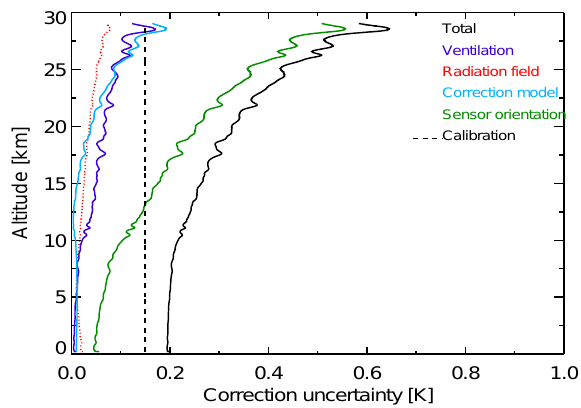
Figure 9. Contributions of the various uncertainty terms to the Fig. 9. Contributions of the various uncertainty terms to the total uncertainty estimate of the GRUAN temper- total uncertainty estimate of the GRUAN temperature correction ature correction for a sounding performed in Lindenberg on 17 September 2013 at 12:00UTC, maximum solar for a sounding performed in Lindenberg on 17 September 2013 zenith angle during the sounding: 36.5 ◦ . The radiation field represents the uncertainty due to the unknown at 12:00UTC; maximum solar zenith angle during the sounding: albedo of the cloudy/cloud-free scene. 36.5 ◦ . The radiation field represents the uncertainty due to the un- known albedo of the cloudy/cloud-free